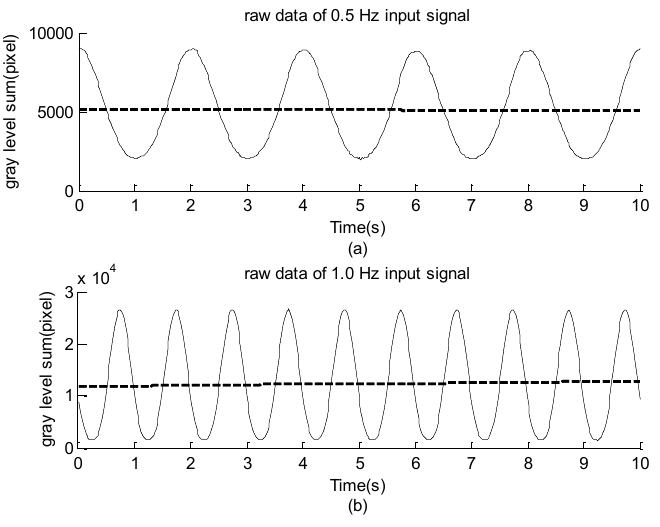
Figure 3. The LED image data of the high speed camera with 10.2 Hz input: solid line is the raw data and dashed line is the smooth